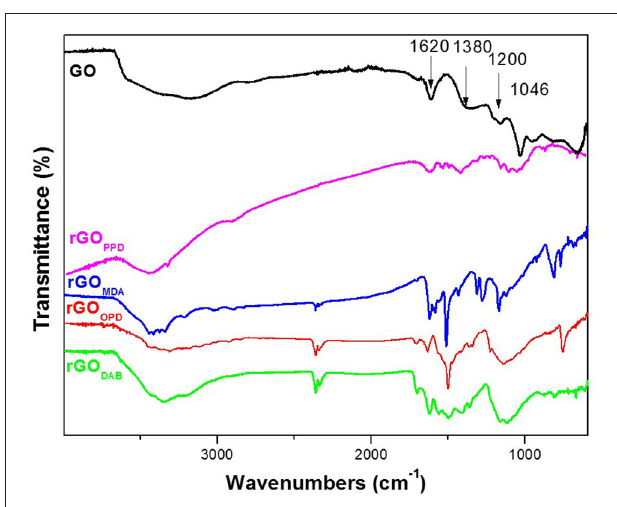
FIGURE 6 | FT-IR spectra of aerogels with aromatic diamines.